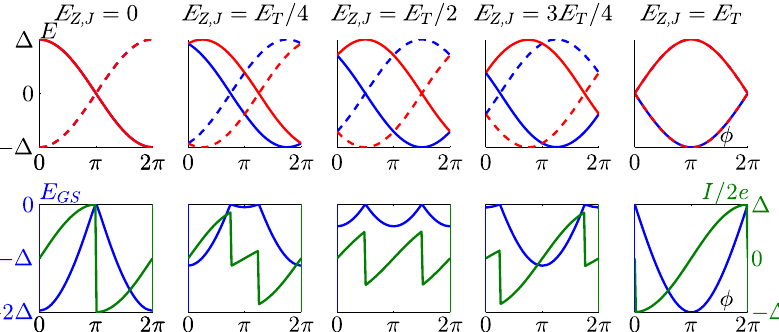
FIG. 10. The upper panel shows the bound-state energies of the two spin species (plotted in red and blue) and the energies of their particle-hole symmetric states (indicated by dashed lines) for a single momentum k varied. The contributions to the ground-state energy (obtained by summing over the negative energy states) and the Josephson current are plotted for each value of the Zeeman field in the lower panel in blue and green, respectively. At E which the energy is minimized shifts from 0 to π . This transition is accompanied by a minimum in the critical